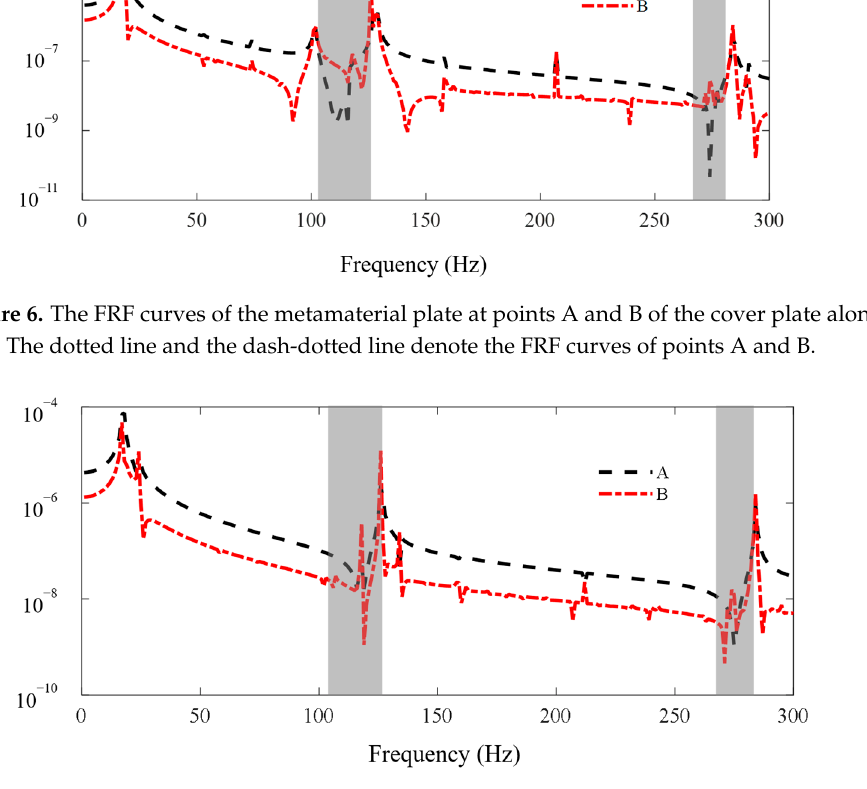
Figure 8. The FRF curves of the metamaterial plates with the beam cores and rod cores near the first axial vibration band-gaps in the z direction of the beams at points A and B of the cover plates. ( a ) Point A and ( b ) point B .